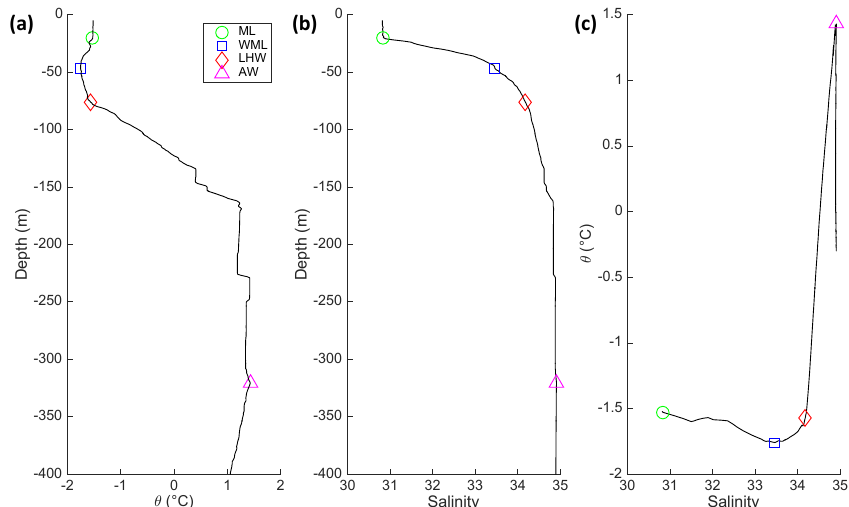
Figure 1. Vertical profiles of (a) potential temperature ( θ ) and (b) salinity, as well as the corresponding θ – S diagram (c) for a single station (station 26) occupied in 2013. The bottom boundaries of the surface mixed layer (SML) and winter mixed layer (WML) are shown by the green circles and blue squares, respectively. The θ – S bend (or kink) that has been typically used to identify the position of lower halocline water (LHW) is shown by the red diamonds. The θ max marking the core of the AW layer is shown by the magenta triangles. The halocline is the layer between the SML and LHW. The reverse thermocline is the layer between the LHW and AW. The base of the WML was determined as the θ min below the SML. The LHW position was computed via the method outlined in Bourgain and Gascard (2011).